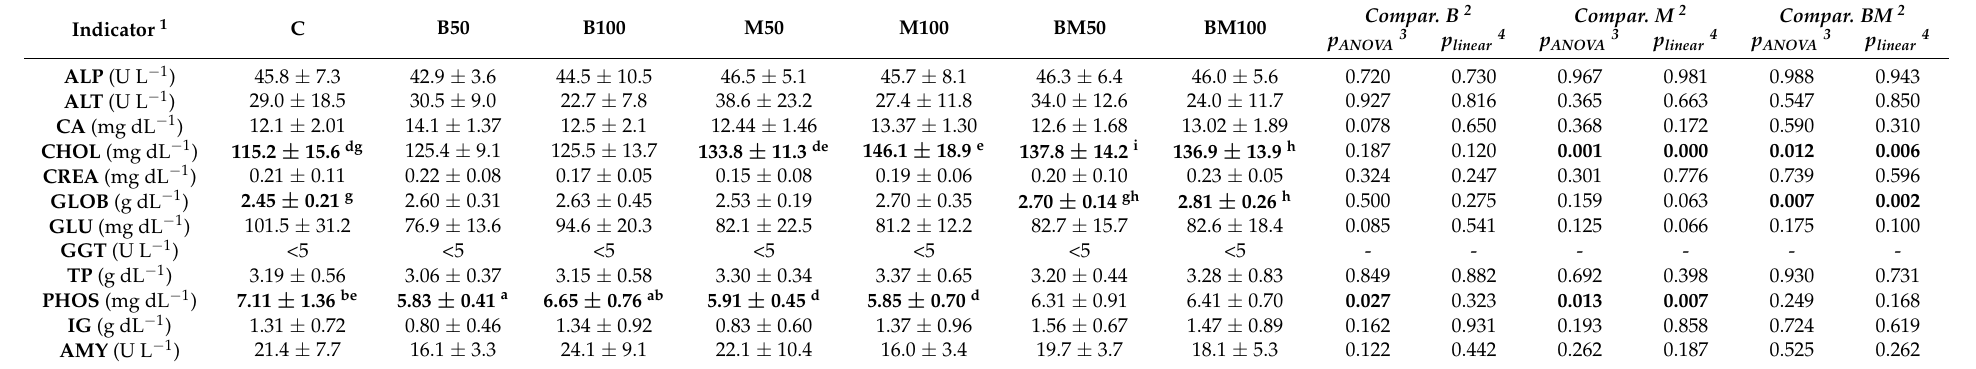
Table 7. Selected blood plasma biochemistry parameters of African catfish fed diets with different inclusion level of M and B (n = 9/diet groups). Indicator